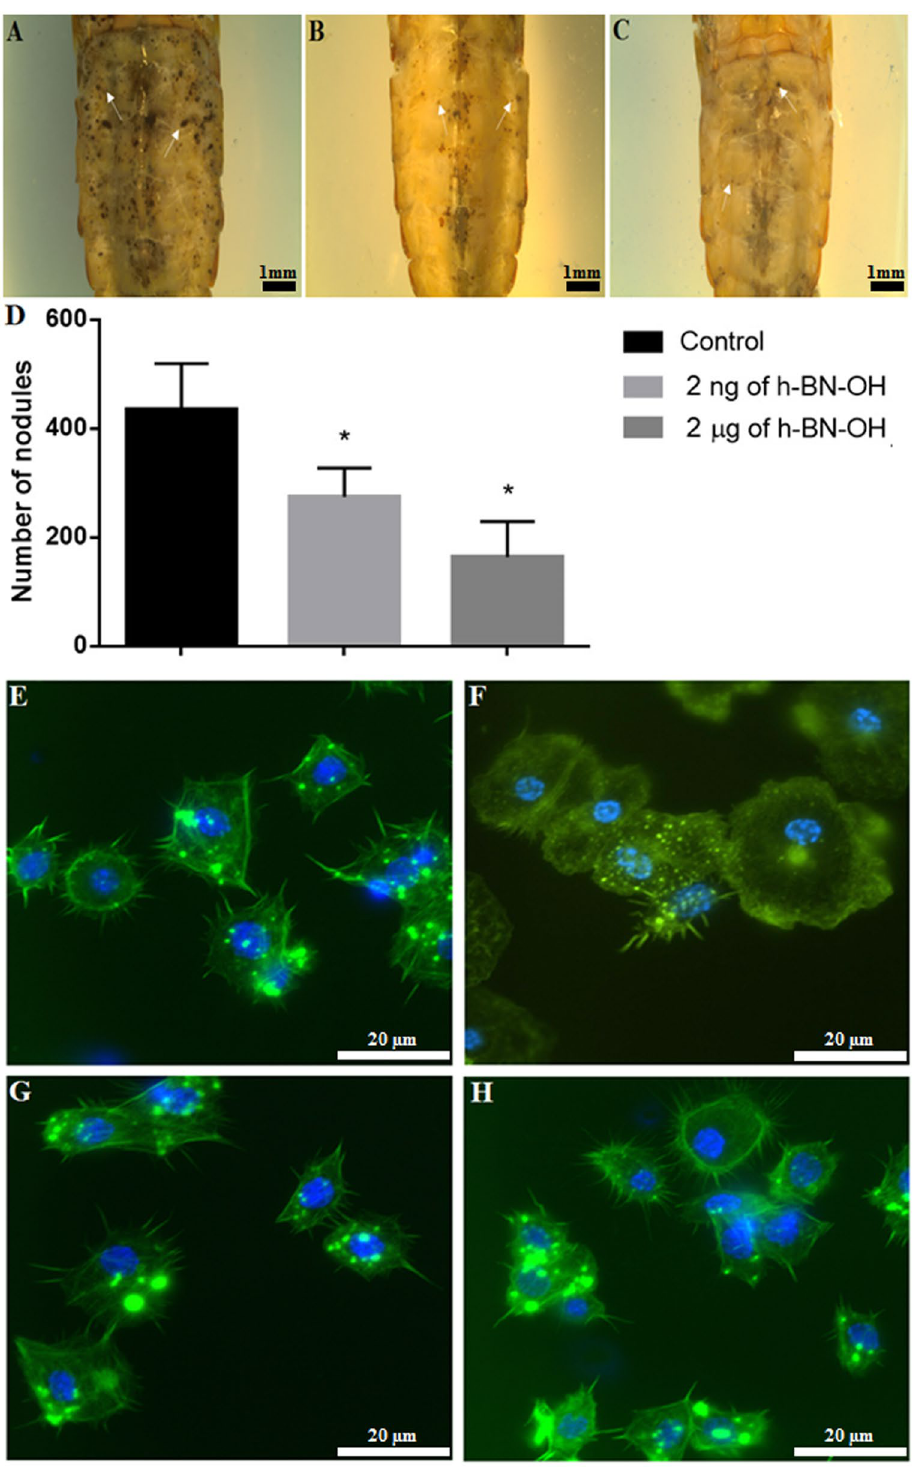
Figure 5. The long-term study of cellular immune response - nodulation and haemocyte viability assay. Tenebrio molitor specimens were topically exposed to saline ( A ; control), 2 ng ( B ) or 2 µ g ( C ) of h-BN-OH-n. Then, nodulation was induced by injection of a Staphylococcus aureus suspension. Arrows show some examples of nodules. Bar: 1 mm. The mean number of nodules formed following the application of saline or h-BN-OH-n ( D ). Values shown are means ± S.D. The results that are significantly different from those of the control group are indicated p < 0.05 ( * ). Haemocyte bioassay showing viable, adhesive haemocytes after topical exposure of insects to saline ( E ), saline ( F ), 2 ng ( G ) and 2 μ g ( H ) h-BN-OH-n and injection with Staphylococcus aureus suspension ( F , H ). The active caspases (1–9) were stained with SR-VAD-FMK (no red = no active caspases), the F-actin cytoskeleton was stained with Oregon Green 488 phalloidin (green) and DNA was stained with DAPI (blue). Scale bars: 20 μ